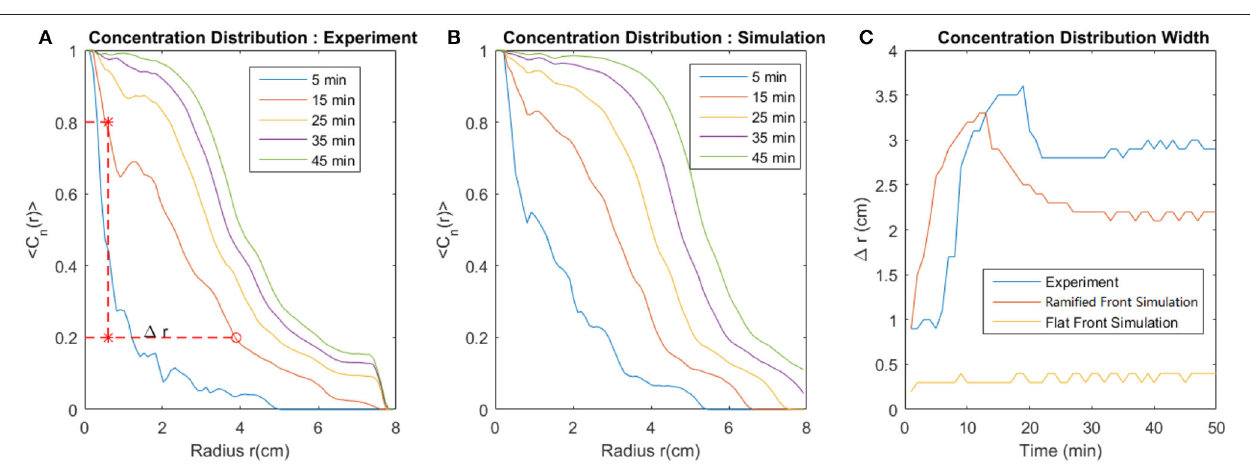
FIGURE 9 | Evolution of the average concentration distribution at different times. (A) Experimental data. (B) Simulation data. The red dotted line in (A) shows how we get the width of concentration distribution at 15 min ( 1 r ( t 25 min )) which is the distance between the red circle (20 % of reference concentration) and red asterisk = (80 % of reference concentration). (C) Displays the width of concentration distribution evolution with time, the blue line is the experimental result, the red line is the simulation with an injection ramified front identical to the dissolution pattern present in this experiment, and the yellow one is the simulation result with a flat circular front of similar area.